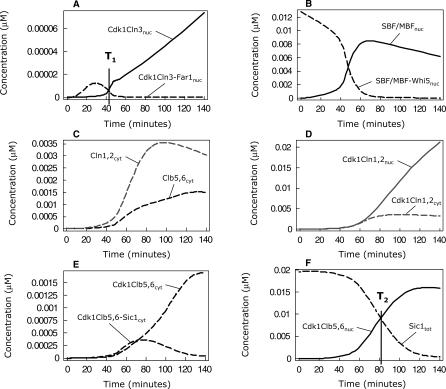
Simulated Time Courses for Protein and Protein Complex Concentrations
T1 and T2 represent the threshold-overcome times. In early G1, cytoplasmic Far1, Cln3, and Cdk1 are imported into the nucleus.(A) Nuclear Cdk1-Cln3-Far1 complex reaches its maximal value after 30 min and becomes degraded upon overcoming the Cln3/Far1 threshold (T
1). Then, Cdk1-Cln3 accrues in the nucleus.(B) At about 50 min the accumulation of active SBF/MBF reaches its half-maximal value.(C) Cln and Clb cyclins are produced in substantial amounts.(D) Cdk1-Cln1,2 is accumulated both in cytoplasm and nucleus.(E–F) Cdk1-Clb5,6 accumulates preferentially in the nucleus.(F) The half-maximal value of nuclear Cdk1-Clb5,6 is reached at around 80 min, thereby setting the value of the second threshold (T2).